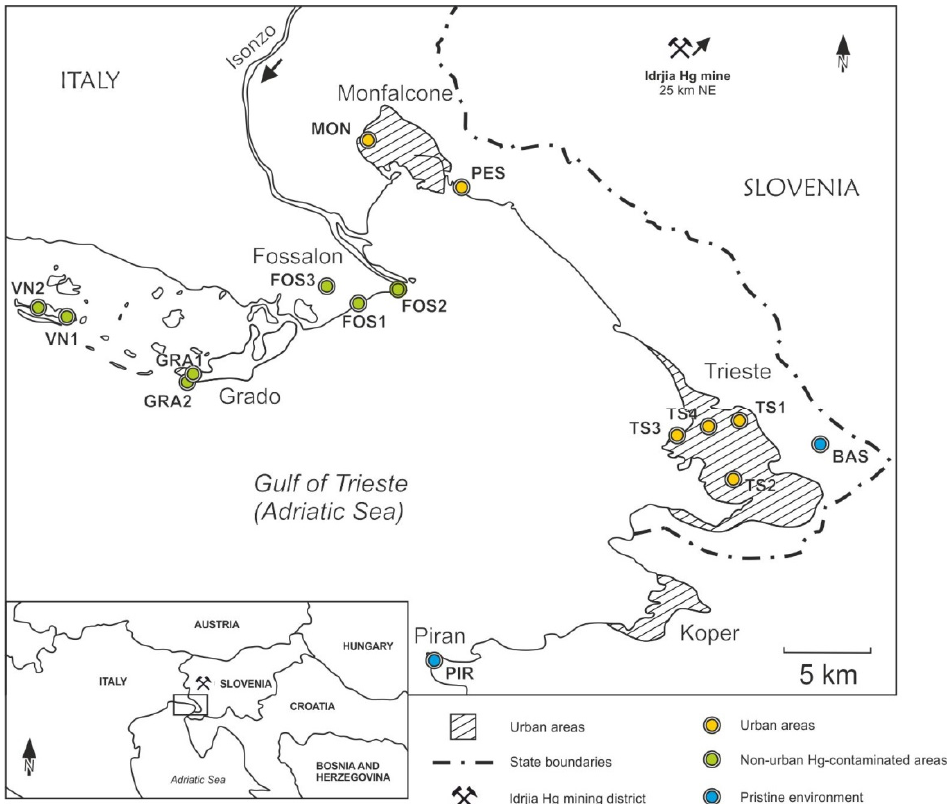
Figure 1. Study area and selected sampling sites: on the lower left the symbol shows the location of the Idrija Hg mine responsible for the contamination of the Isonzo River Plain and the Gulf of Trieste.